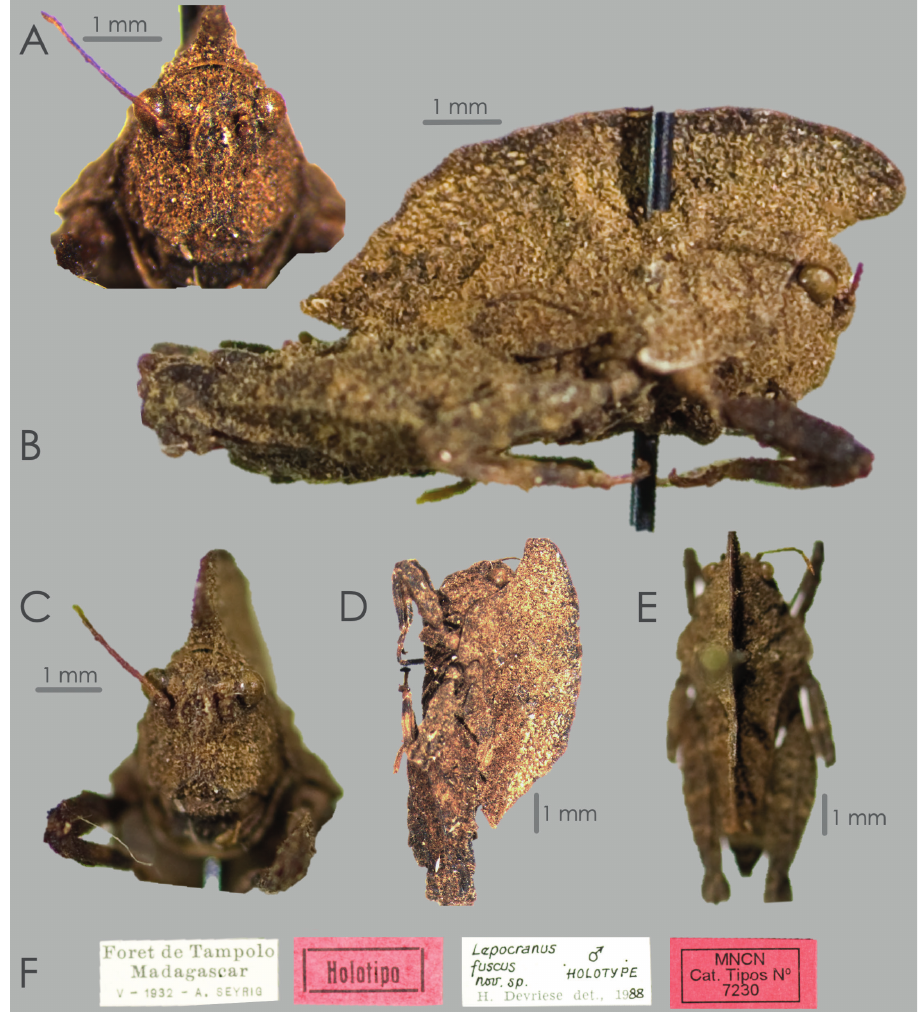
Figure 1. Lepocranus fuscus Devriese, 1991 A head detail in frontal view B habitus in right lateral view C habitus in frontal view D habitus in light lateral view E habitus in dorsal view F labels. Photo: J. Skejo and MNCN